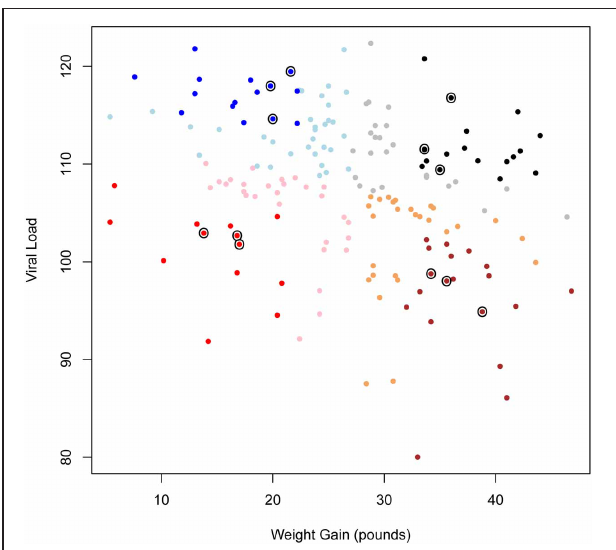
FIGURE 1 | Scatterplot of weight gain vs. viral load for all pigs in PHGC trial one. Each dot represents a pig. Color shadings indicate the four different phenotpypic groups (HvHg, HvLg, LvHg, and LvLg). Dark color indicates pigs that were classified into one of the groups. Light color indicates pigs that were not classified because they lay in the boundary of the groups. Circles indicate pigs that were selected for transcriptional profiling in this